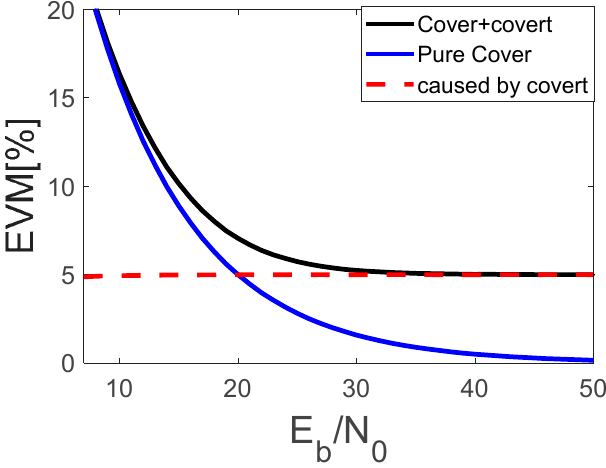
Figure 5. EVM introduced by covert signal on the cover signal constellation.